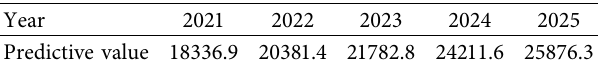
Table 5: GM-Markov prediction of per capita disposable income of rural residents in China from 2021 to